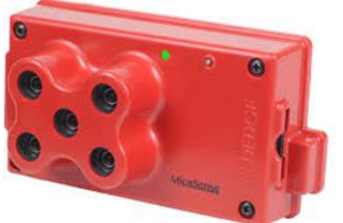
Figure 2: Micasense RedEdge multispectral camera. Table 1. RedEdge multispectral specifications.